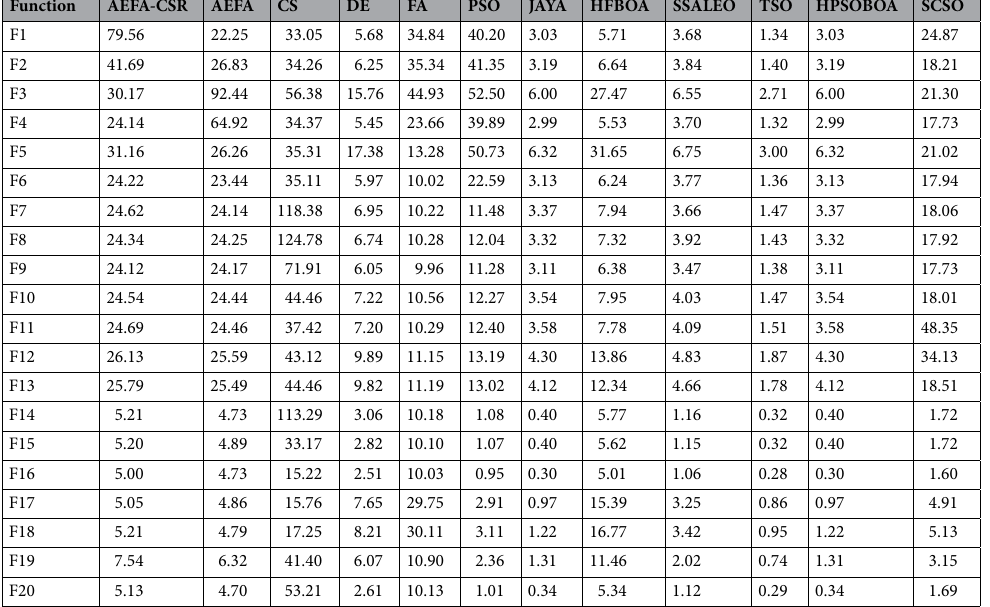
Table 12. CPU time comparison for benchmarks at dimension = 30 and population = 30.